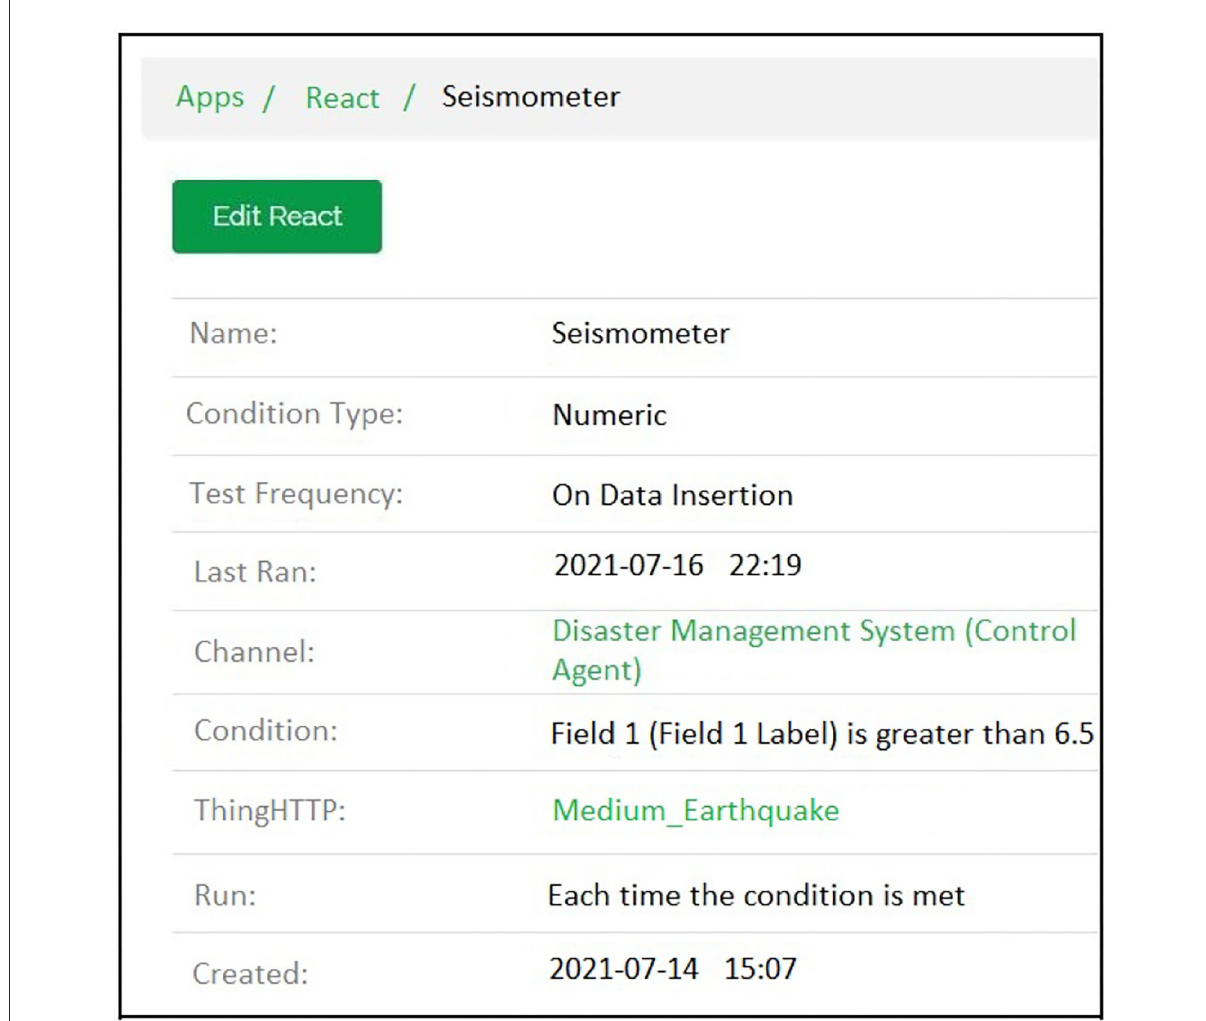
FIGURE12 IFTTT notification react created for connecting ifttt platform with the thingspeak